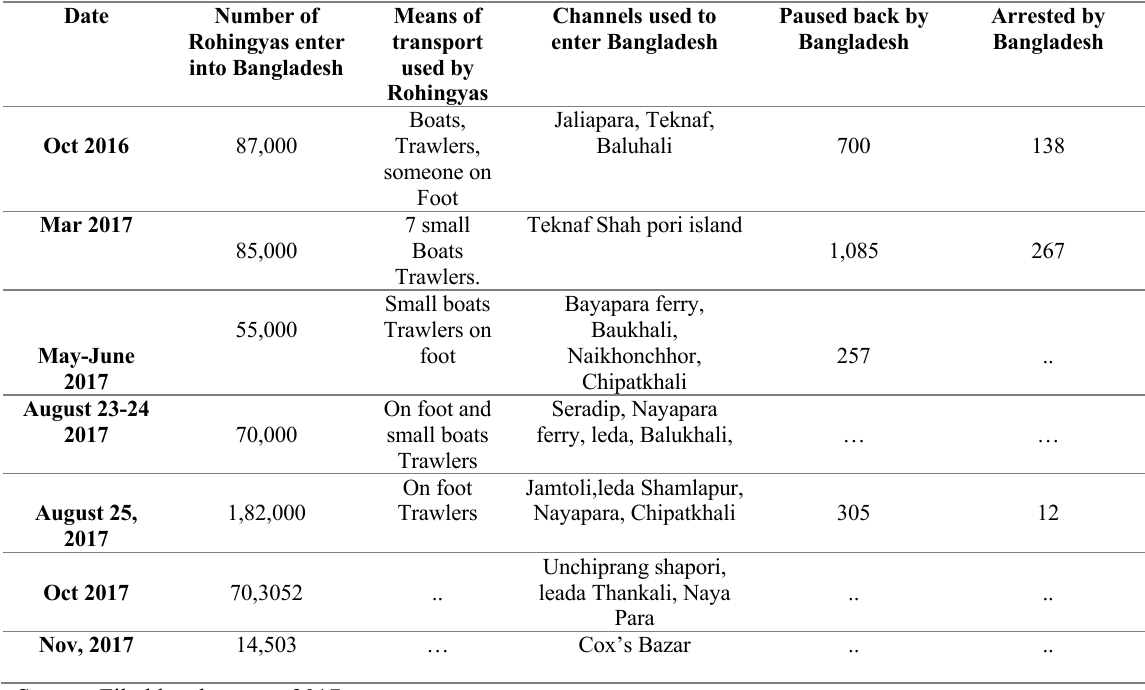
Table 4: A Report of Bangladesh’s Push Back Policy (Oct 2016- Nov